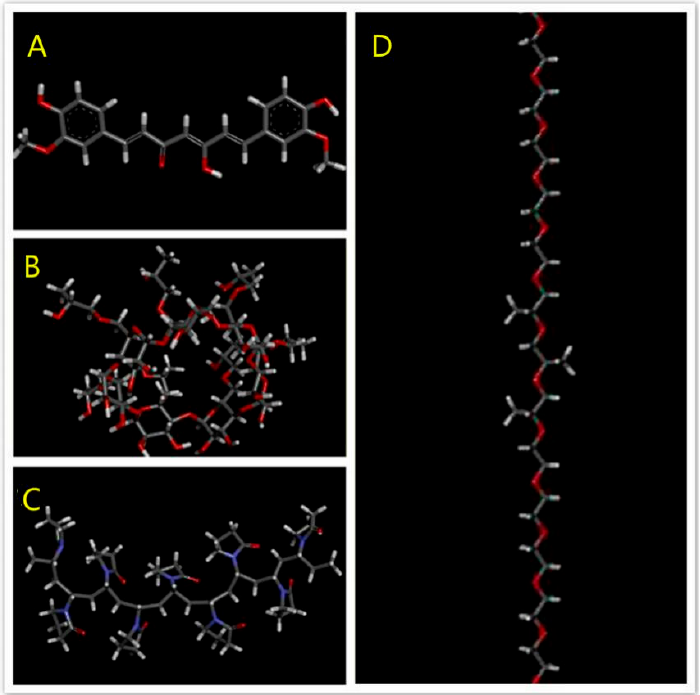
Figure 2. The molecular model of ( A ) Cur, ( B ) polyvinylpyrrolidone (PVP), ( C ) HP- β -CD (HCD), and ( D ) polyxamer 188